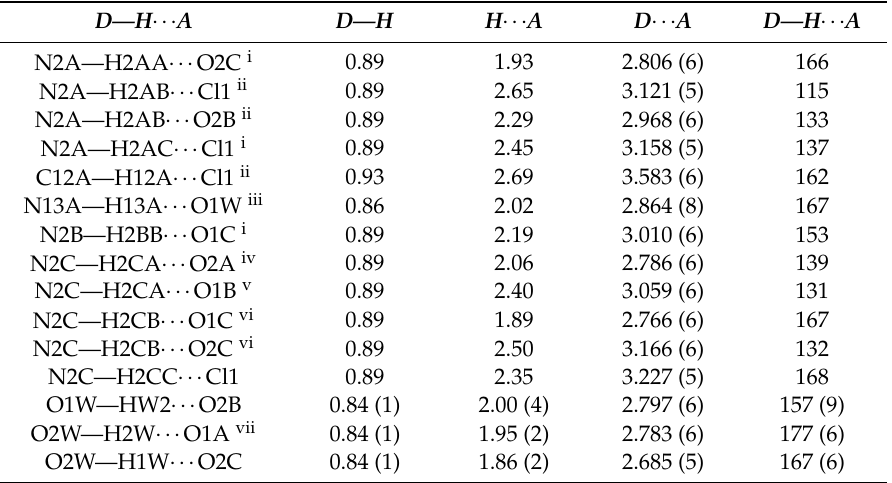
Figure 5. The intermolecular hydrogen bonds (strong bond—red, moderate—blue). Table 2. Hydrogen-bond geometry (Å , °).